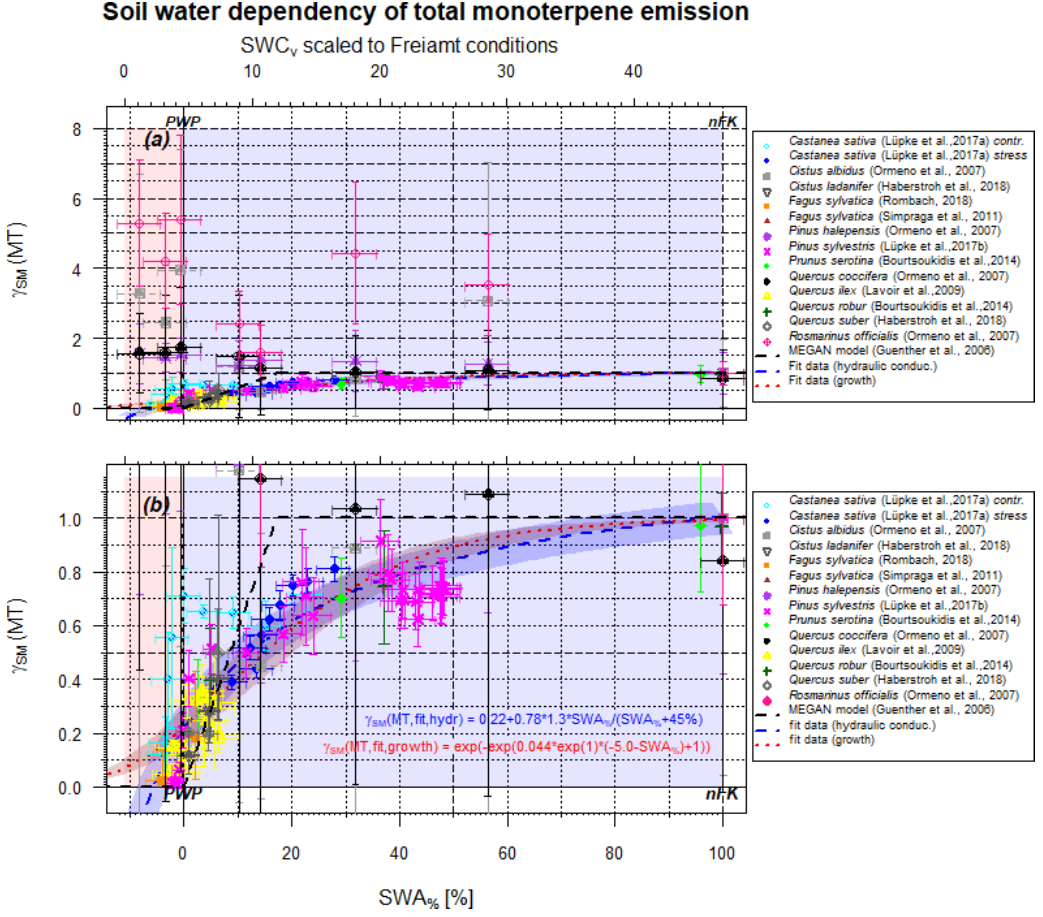
Figure 2. Scaling parameter γ SM (MT) for the effect of soil moisture on isoprene emissions as a function of SWA % (lower x axis) and, for comparison, the SWC v for a selected condition (upper x axis). The upper plot (a) displays the full data range, while the lower plot (b) zooms vertical area between 0 and 1.2. Data points represent observations, and different colors refer to different studies. The dashed black line displays the approach by Guenther et al. (2006, 2012) for isoprene only. The red line displays the present form using hydraulic conductivity as driving force, and the dark red line displays the biological growth stress as driving